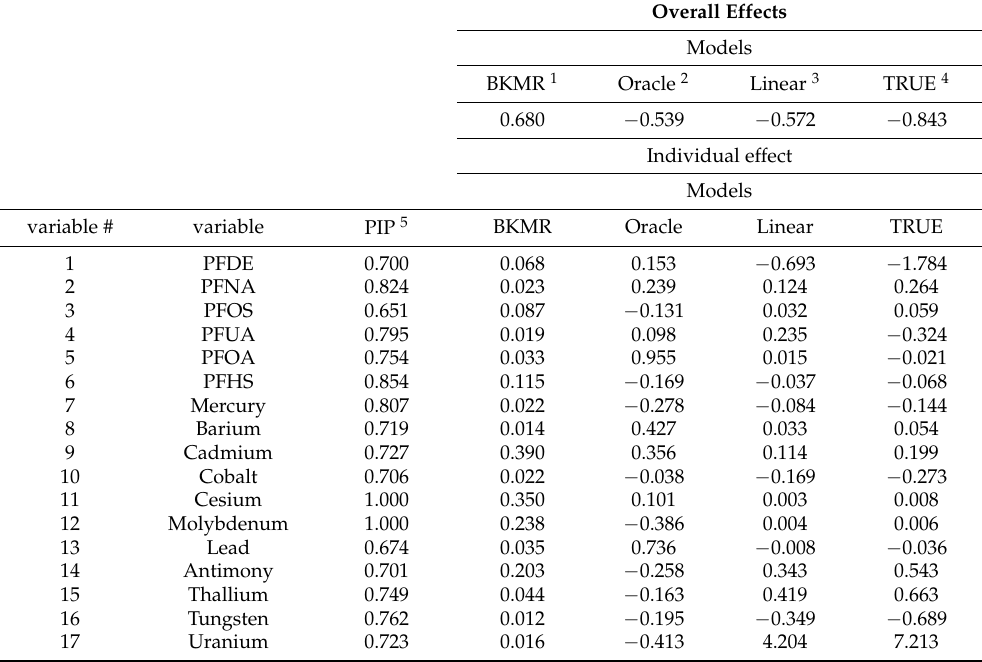
Table 1. Posterior inclusion probability (PIP) and comparison of four models (BKMR, Oracle, Linear, and True) of overall health effects on the response variable (AL) by